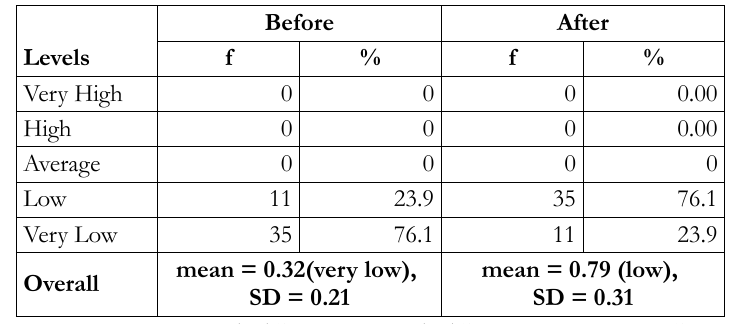
Table 7. Level of Problem Solving Skills of the PBL Group before and after Exposure to PBL